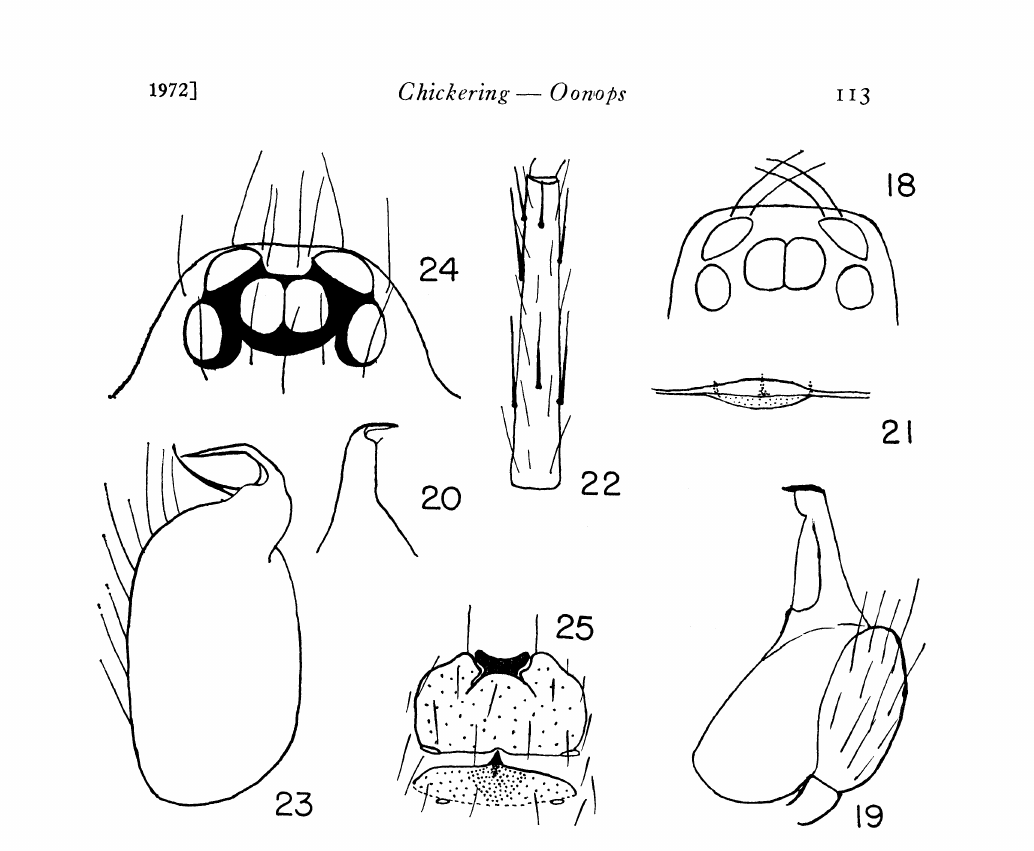
Figures 18-21. Oonops globimanus Siinon. Fig. 18. Eyes of male from above. Fig. 19. Right palpal tarsus of male; prolateral view. Fig. 20. Dis- tal end of left palpal tarsus; nearly dorsal view. Fig. 21. Epigynal area of female from below. Figures 22-23. Oonops .alidus Bryant. Fig. 22. Right first metatarsus; dorsal view. Fig. 23. Left palpal tarsus of holotype from below. Figures 24-25. Oonops .iridans Bryant. Fig. 2. Eyes from above. Fig. 25. Epigynal area and articulation of abdomen and